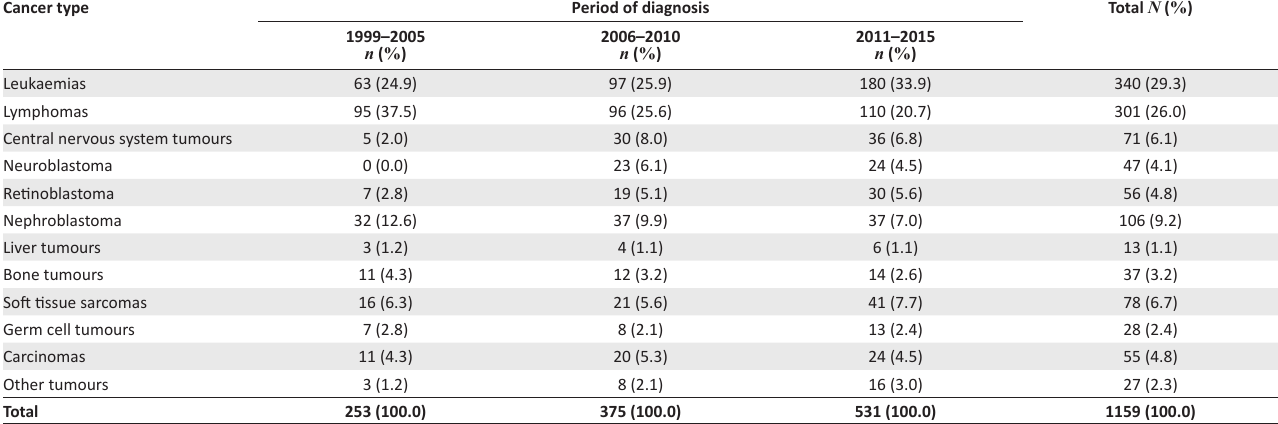
FIGURE 1: Population pyramid of Sudan, TABLE 3: The number and relative frequencies of childhood cancers by period of diagnosis ( n = 1159). Cancer type